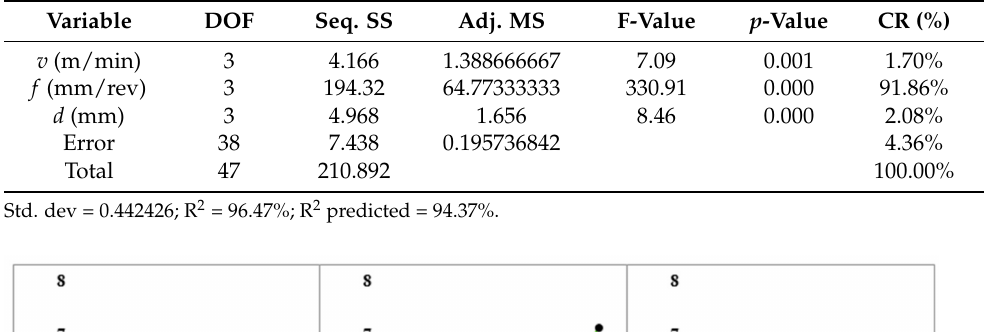
Table 14. Analysis of variance and percentage contribution results for Ra.